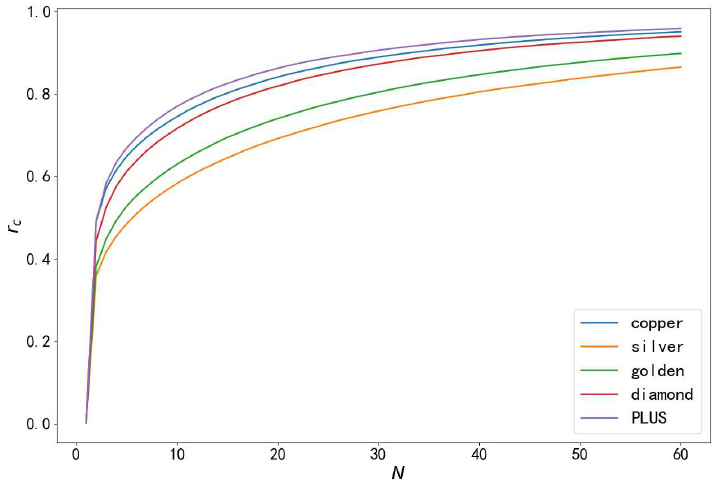
Figure A7. r c curve for all five user levels. The x -axis shows N , the number of the most similar words chosen to form the network, and the y -axis shows the value of r c . Five curves with different colors represent the five user levels. For the selection of N , we aimed at the one with or near the largest second derivative on the curve, which refers to the most effective or representative part that is contained in the network. Therefore, N = 4 was determined, with N = 5,6,7 to prove the